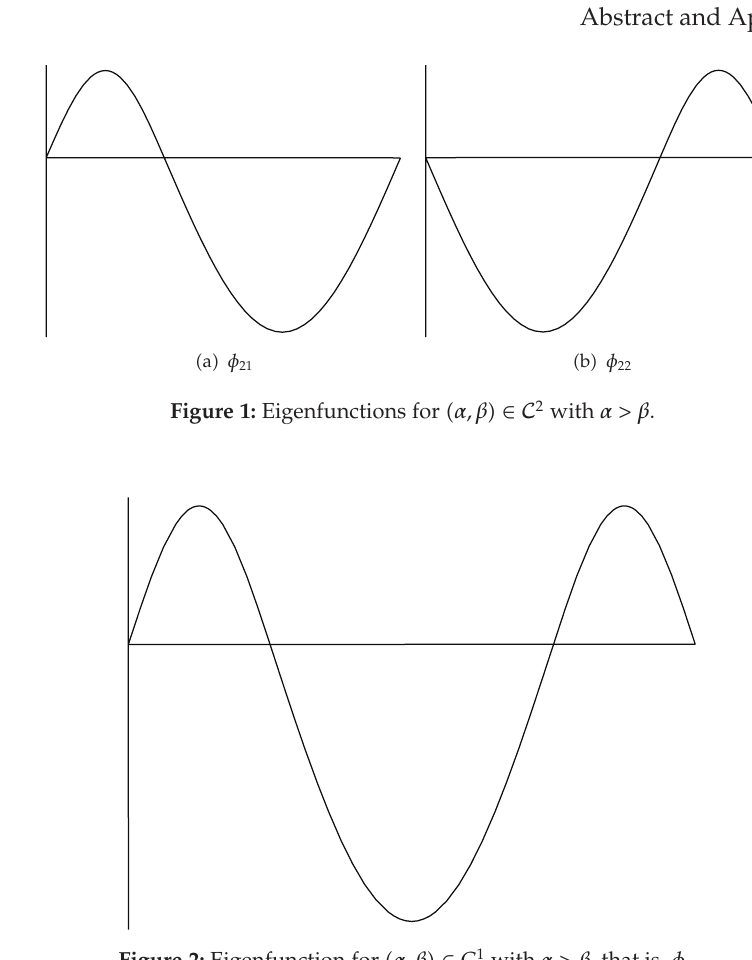
with α > β , that is, φ 31 3